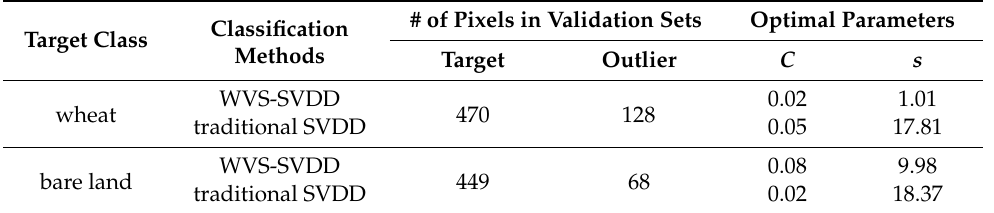
Table 1. Numbers of target and outlier pixels in the validation sets for traditional and window-based validation set for support vector data description (WVS–SVDD) wheat and bare land classifications. The optimal parameters for each classification are also listed. C : tradeoff coefficient; s : kernel